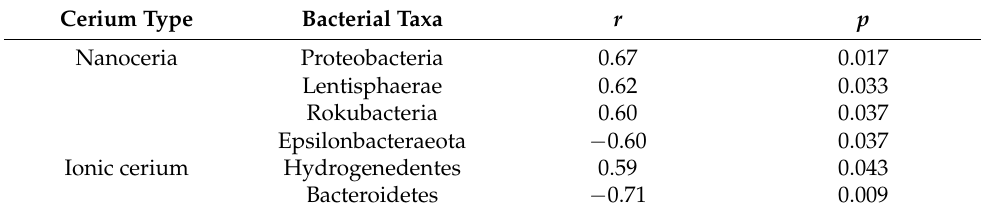
Table 2. Bacterial taxa significantly correlated with cerium dose at the phylum